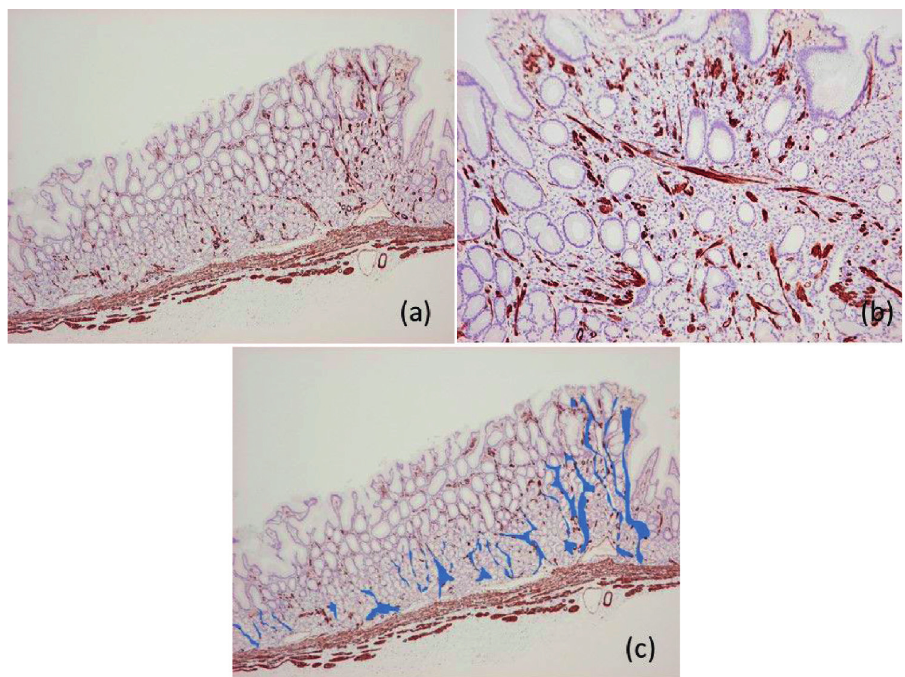
Figure 3: (a) Fibromuscular obliteration by α -smooth muscle myosin observed around the pyloric glands in the background mucosa surrounding the lesion; in places, this extends as if to support the foveolar epithelium. (b) Inside the lesion, fibromuscular obliteration seems to support the foveolar epithelium. (c) Schema representing fibromuscular obliteration. Fibromuscular obliteration is surrounded by blue